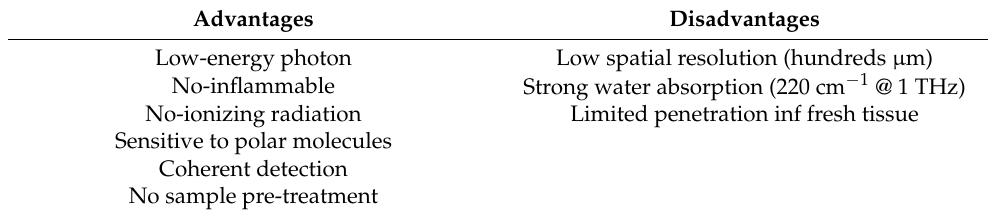
Table 1. Summary of THz spectroscopy. Advantages and disadvantages as a detection